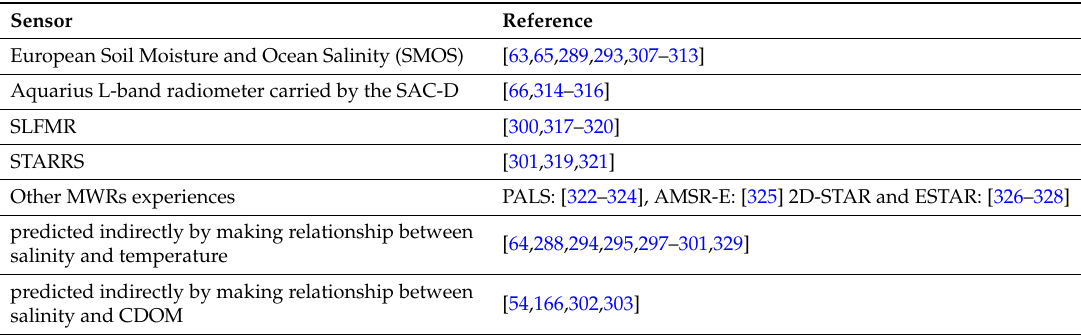
Table 11. Remote sensing of Sea Surface Salinity (SSS) based on the used sensor.